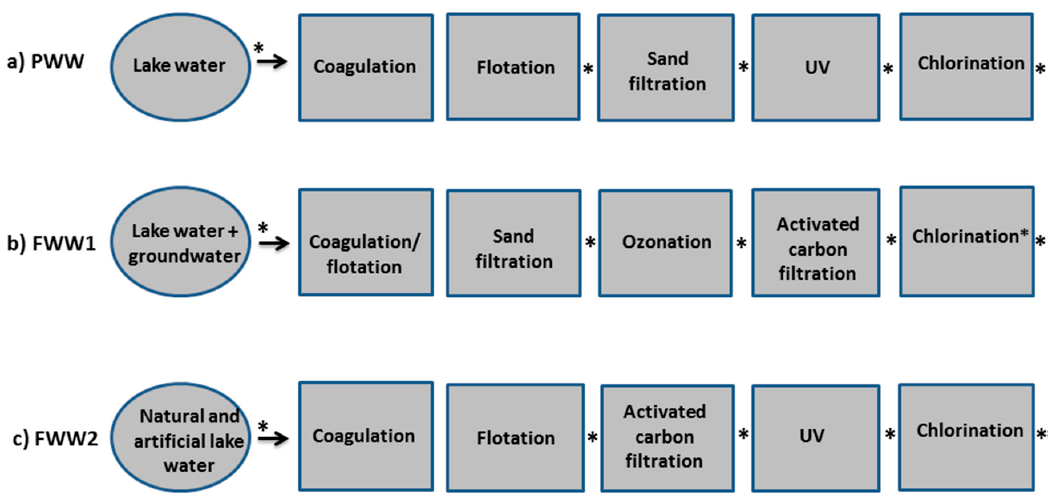
Figure 1. Water treatment unit processes in ( a ) pilot scale waterworks (PWW), ( b ) full-scale waterworks 1 (FWW1), and ( c ) full-scale waterworks 2 (FWW2). * Sampling point.